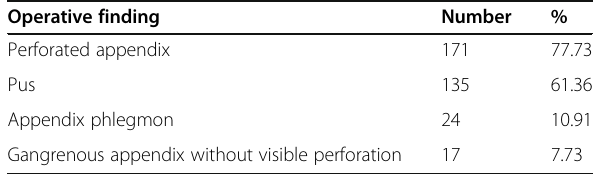
Table 3 Operative findings in appendicular mass Operative finding